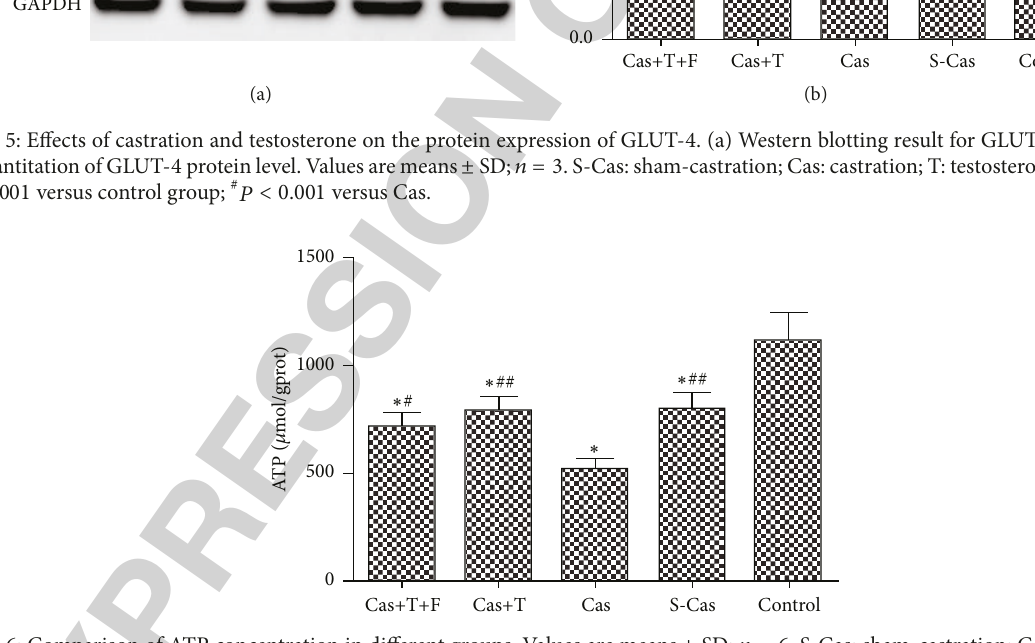
Figure 6: Comparison of ATP concentration in different groups. Values are means ± SD; 𝑛 = 6 . S-Cas: sham-castration; Cas: castration; T: testosterone; F: flutamide. ∗ 𝑃 < 0.001 versus control group; # 𝑃 < 0.01 and ## 𝑃 < 0.001 versus Cas.